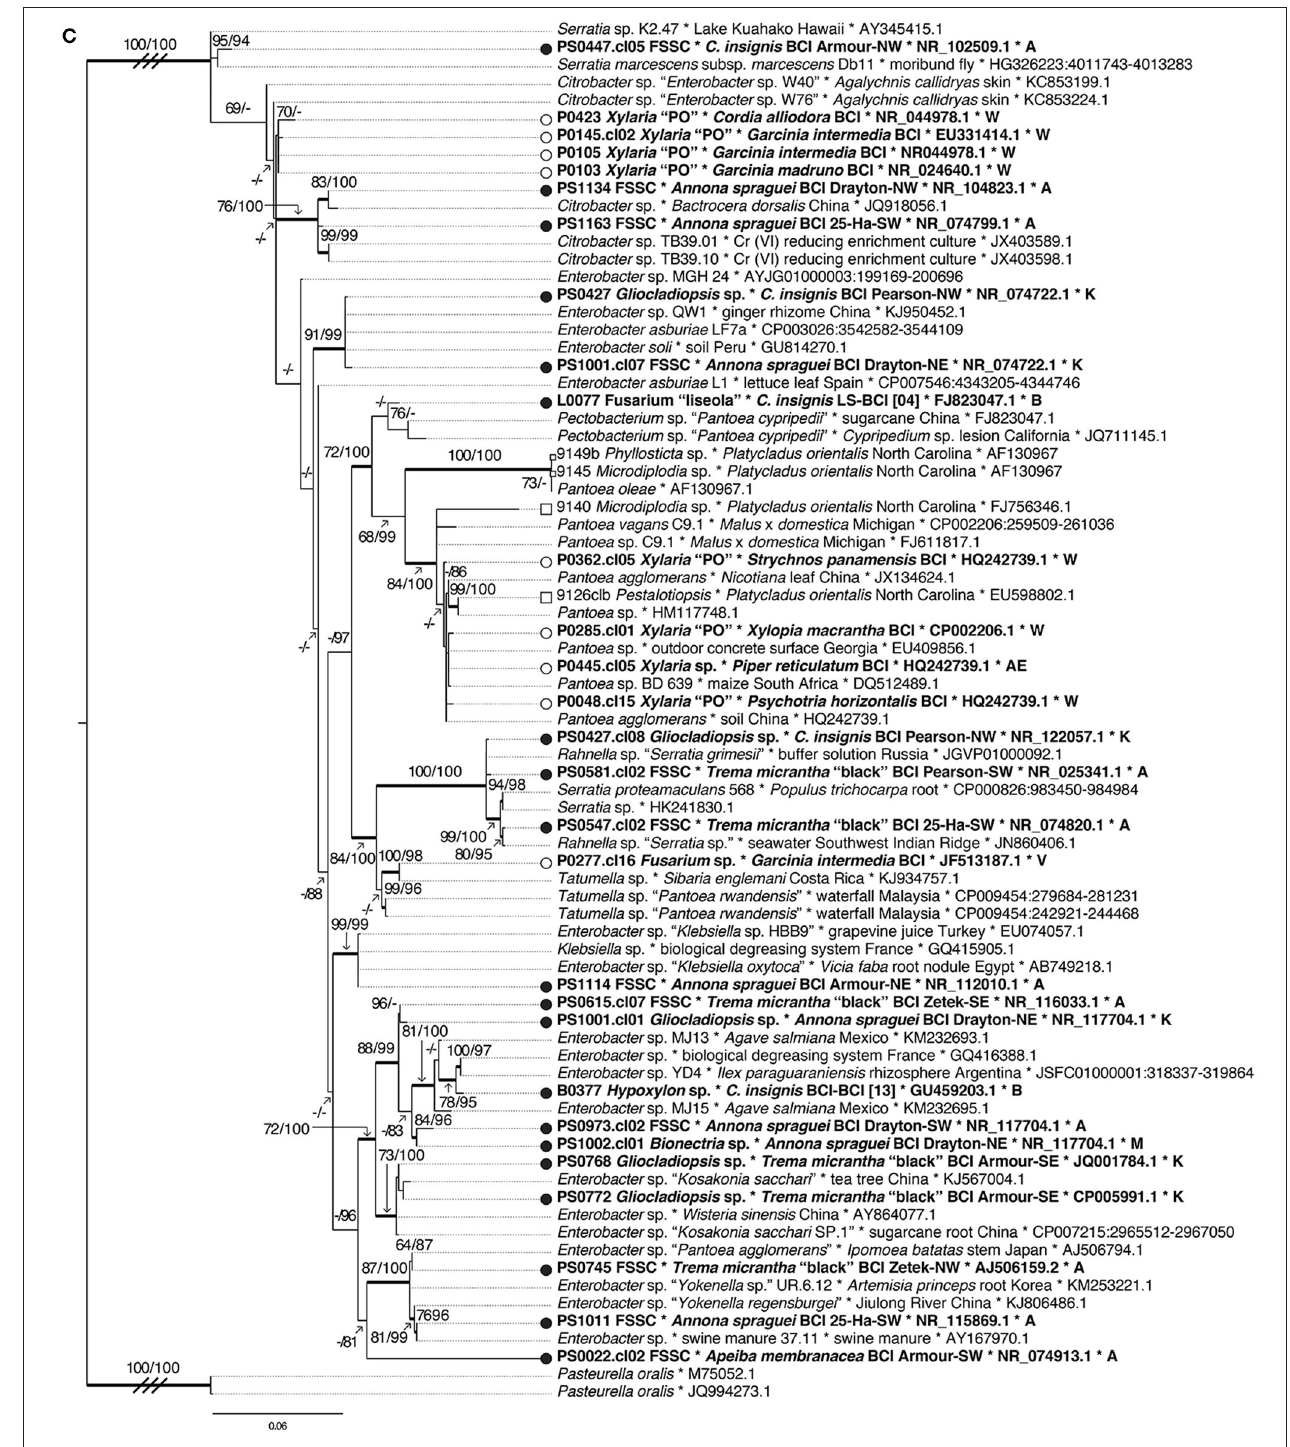
Figure 1). The majority of the remaining sequences are from fungi associated with wood or soil from other Central American, South American, or Asian tropical forests. Two exceptions